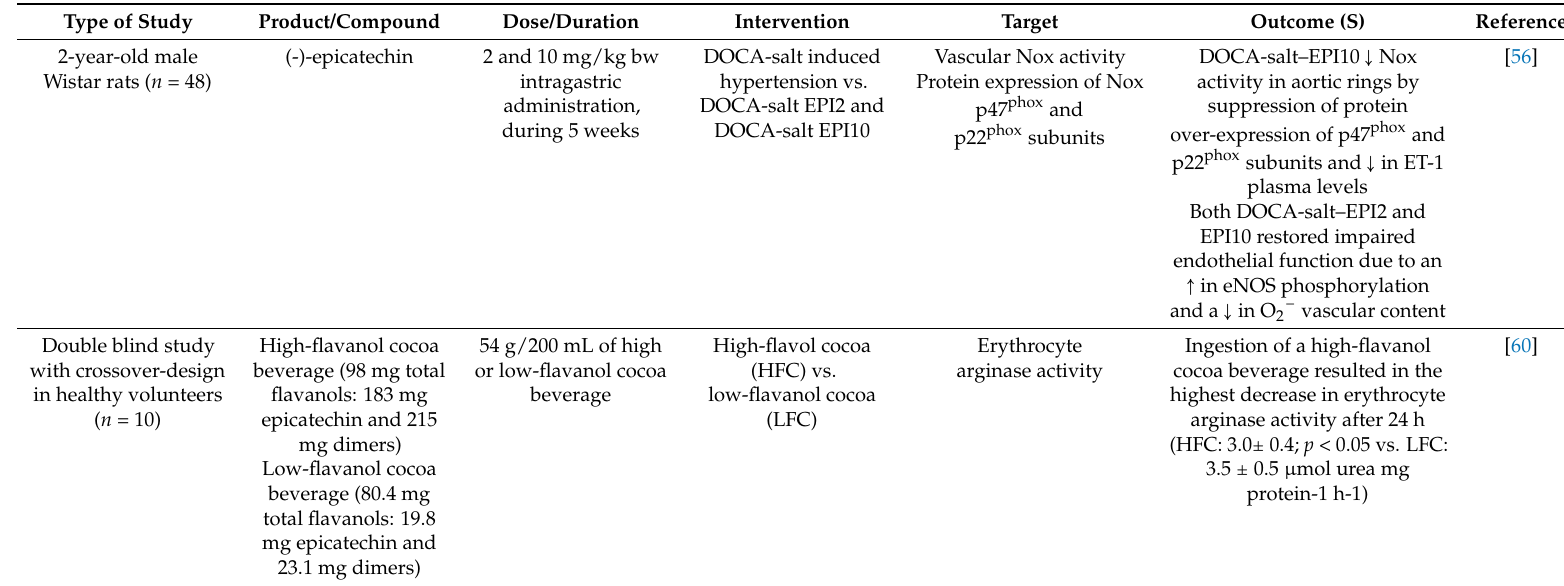
Table 2. Flavanols: antioxidant and anti-inflammatory